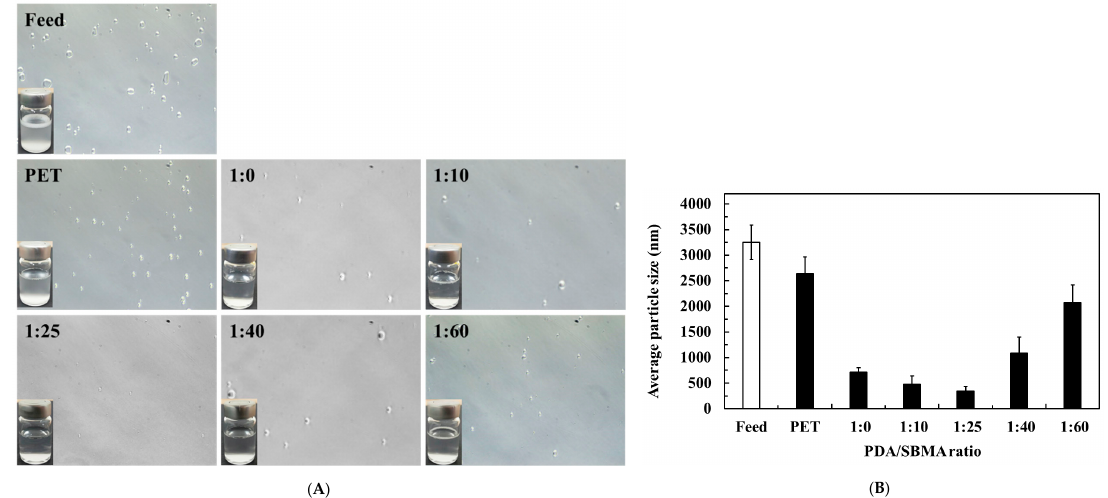
Figure 8. ( A ) Digital images and micrographs of the sodium dodecyl sulfate (SDS) stabilized hexane-in-water emulsion and the filtrate. ( B ) The droplet size of the hexane/water emulsion before and after separation was analyzed by DLS. Table 2. The deposition conditions via mussel-inspired modification approaches.